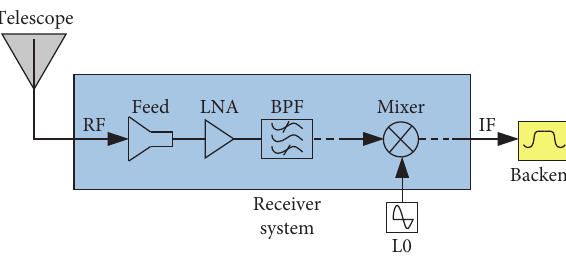
Figure 1: Signal transmission link of receiver.